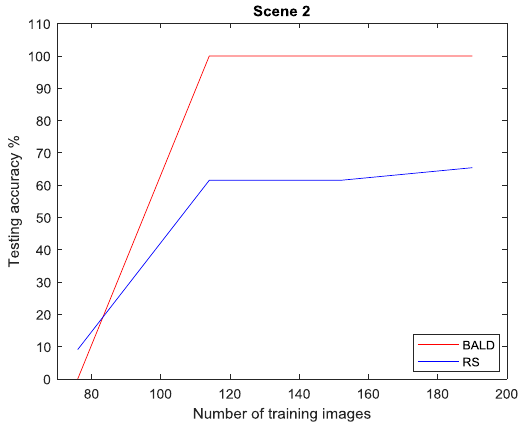
Figure 7 . Test accuracy as a function of the number of training images. Results from the acquisition functions Bayesian active learning disagreement and random sampling are demonstrated for “Scene